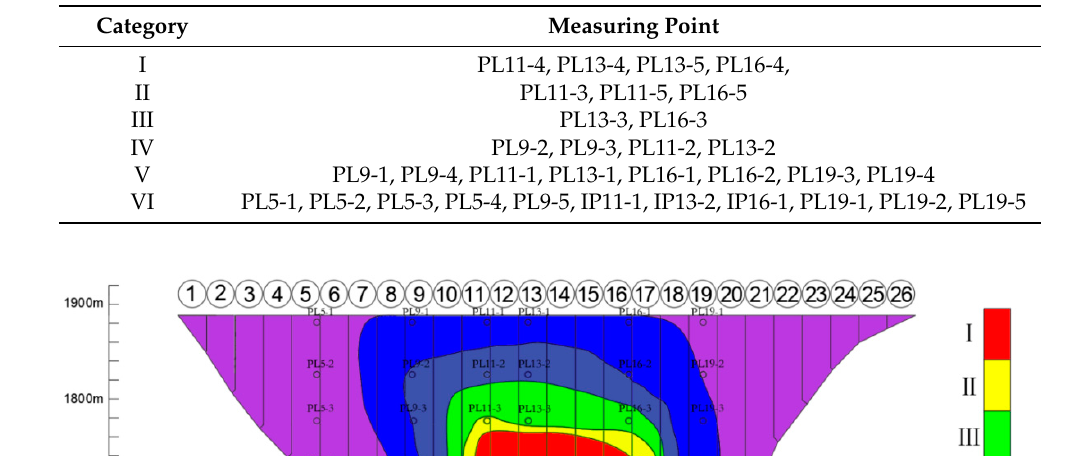
Figure 8. Deformation partition diagram of the ultra-high arch dam during the second phase. Table 3. Zoning results of deformation measuring points of the ultra-high arch dam during the third phase.